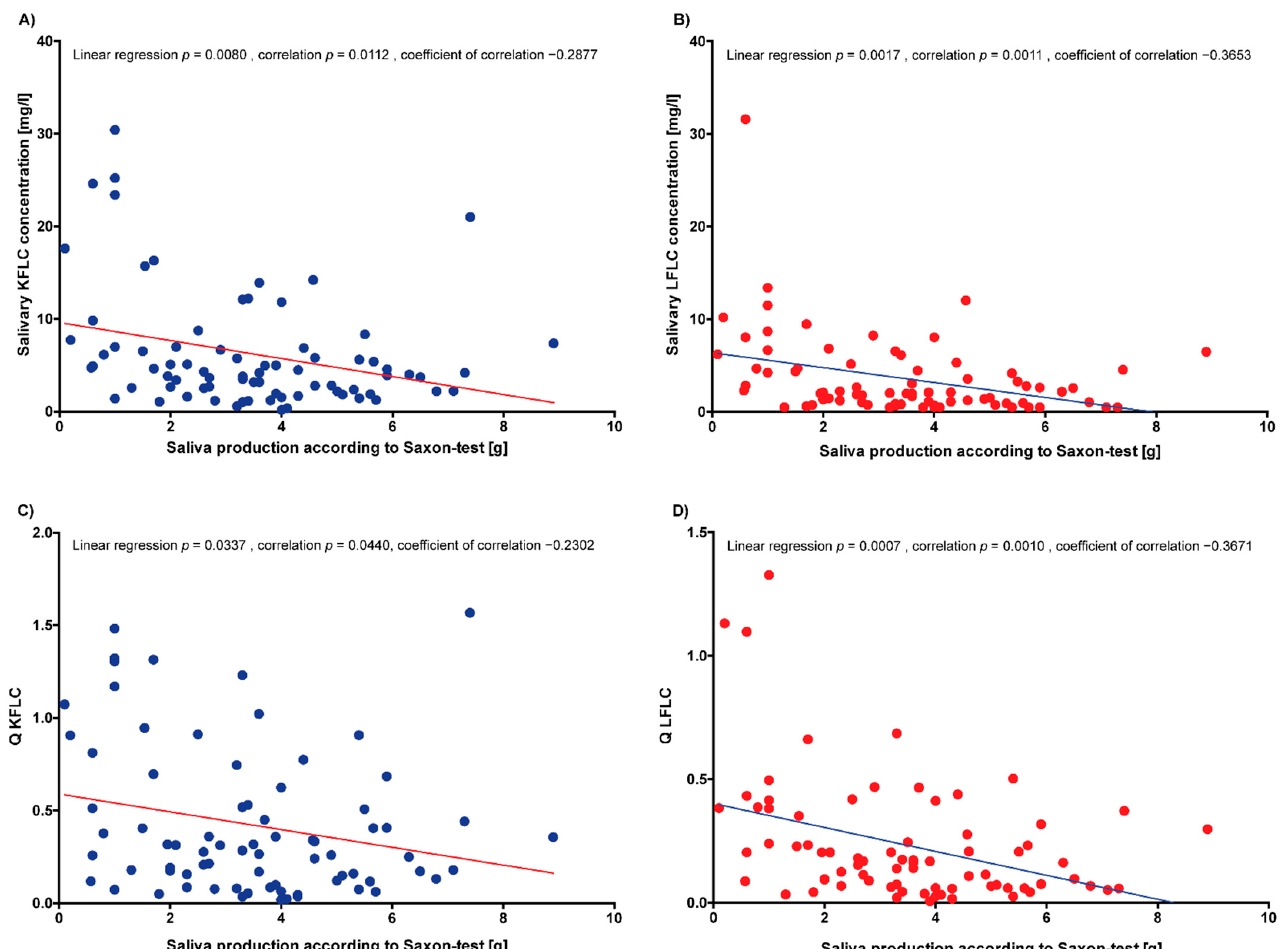
Figure 1. Correlations of saliva protein concentrations and quotients with saliva production. ( A ) KFLC = kappa free light chains; ( B ) LFLC = lambda free light chains; ( C) Q KFLC = saliva/serum KFLC concentration quotient; ( D ) Q LFLC = saliva/serum LFLC concentration quotient.